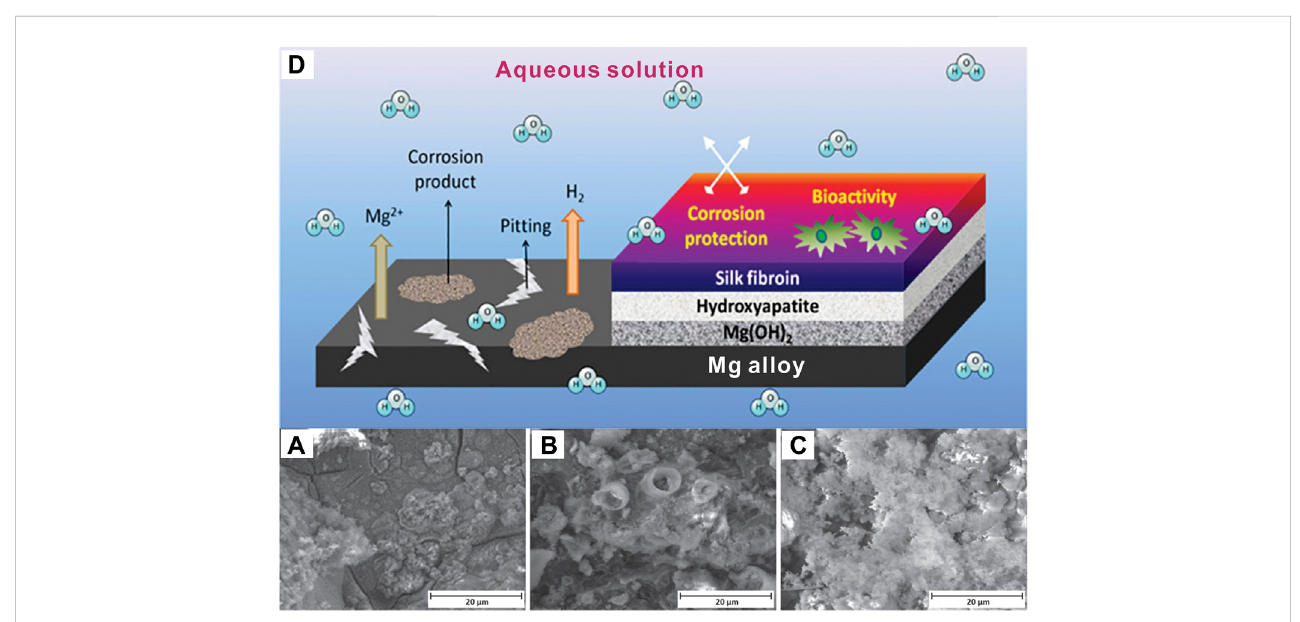
FIGURE 10 Comparison ofthedegradationof (A) pureMg, (B) Hydroxyapatite onMg, (C) Silk fi broin+hydroxyapatite onMg,afterimmersioninHank ’ ssolutionfor7